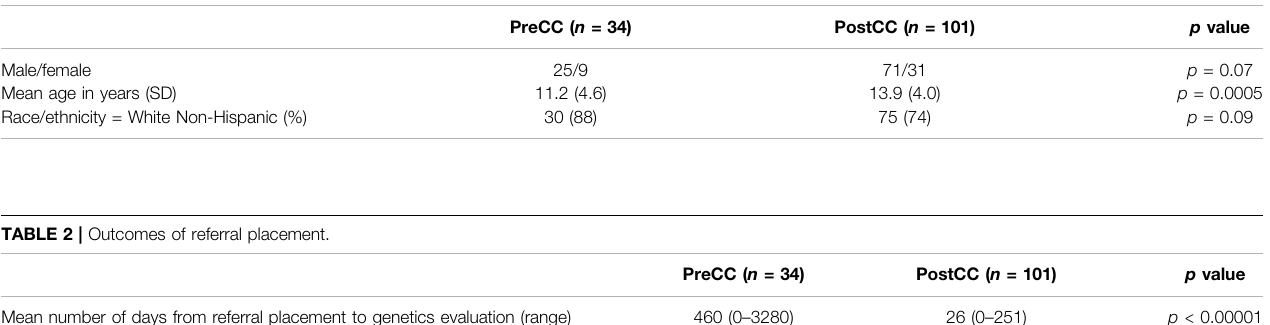
Frontiers in Genetics |